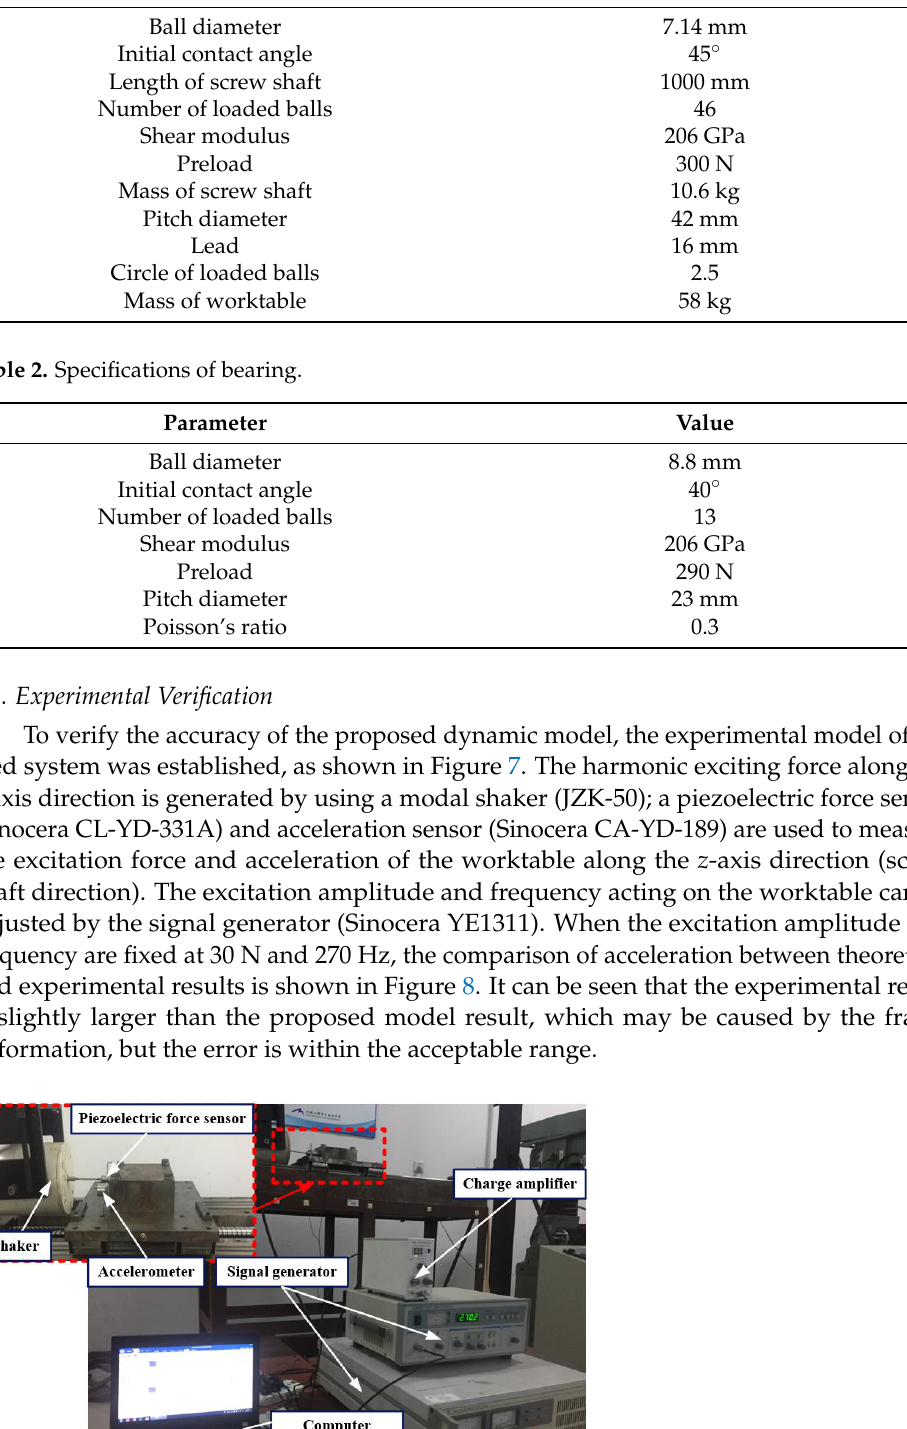
Figure 8. Acceleration comparison along z -axis between theoretical and experimental results. 3.2. Effects of Axial Excitation Amplitude on Axial Vibration of the Feed System It is widely known that the axial vibration of the worktable is the key factor for the machining accuracy and stability of the feed system. For axial excitation amplitudes F a =